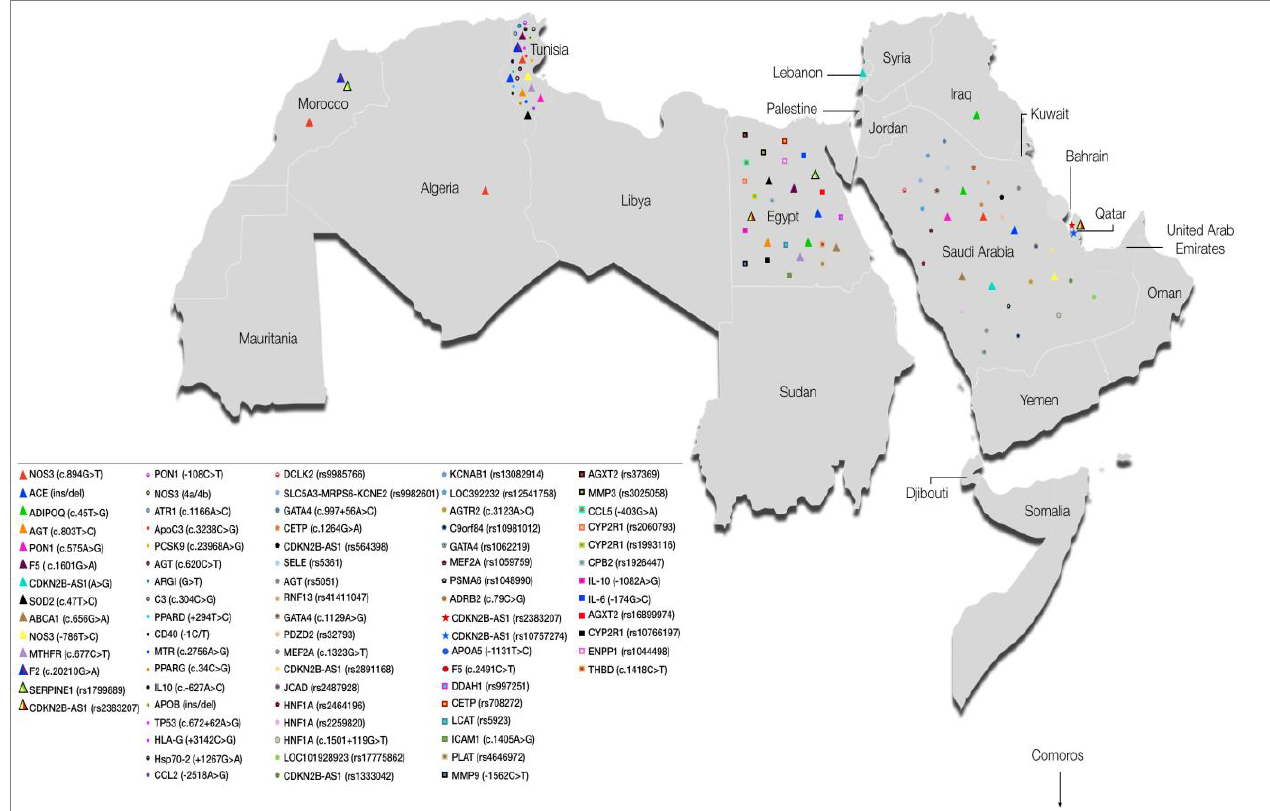
Figure 2. Distribution of CAD/MI-related genetic variations in the Arab world. A total of 80 CAD/MI-associated variants were captured in eight Arab countries. The most common variant detected among Arab patients was NOS3: c.894G>T (rs1799983), which was reported with significant positive CAD/MI associations in four different Arab countries (Morocco, Algeria, Tunisia, Saudi Arabia). No significant genetic association data were captured from 14 of the 22 Arab countries